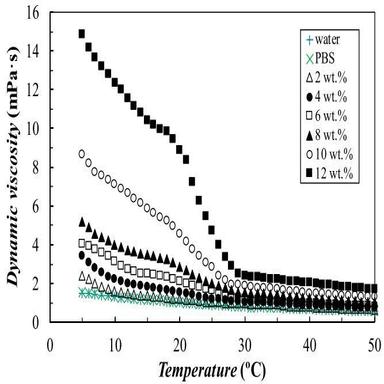
Apparent viscosity− temperature curves obtained at a constant shear rate ofγ ˙ = 10 s − 1 while heating at β = 0.1 ◦C/min for bulk water, the phosphate buffer solution (PBS) and optimized C18Me:C16:C14Me− in− water nanoemulsions prepared with different percentages of dispersed phase (2–12 wt%).